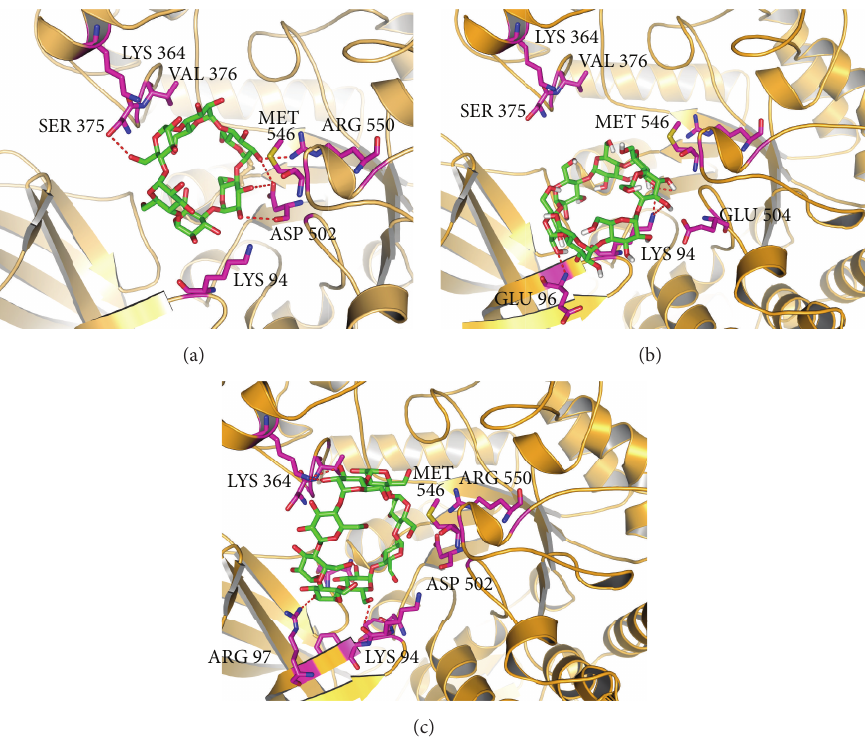
Figure 4: Docking of cyclodextrins into the active site of the Tk1770 CDase. (a) Complex of Tk1770 CDase with 𝛼 -CD and residues involved in interactions. (b) The docked conformation and 𝛽 -CD with TK1770 CDase. (c) The active site residues of Tk1770 interacting with 𝛾 -CD. The hydrogen bonds between substrate and amino acids are represented as red